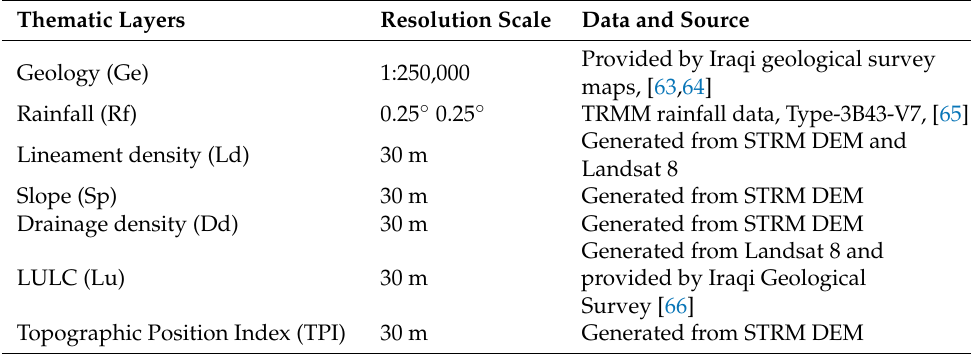
Table 2. Details of source data in this study.